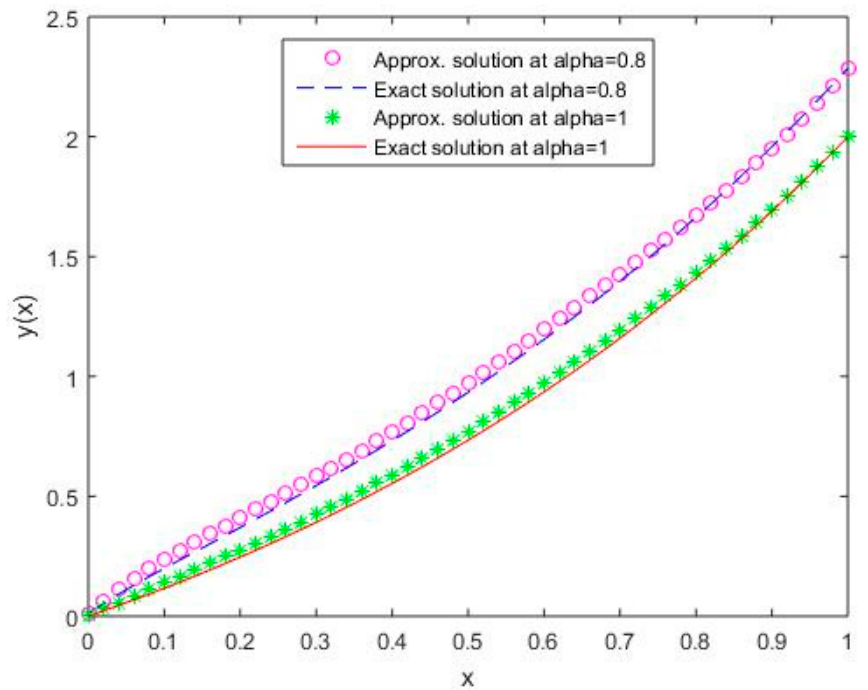
Figure 13. Comparison of exact and numerical solutions using S3 for 𝛼 = 0.8 and 𝛼 = 1 , Example 2.